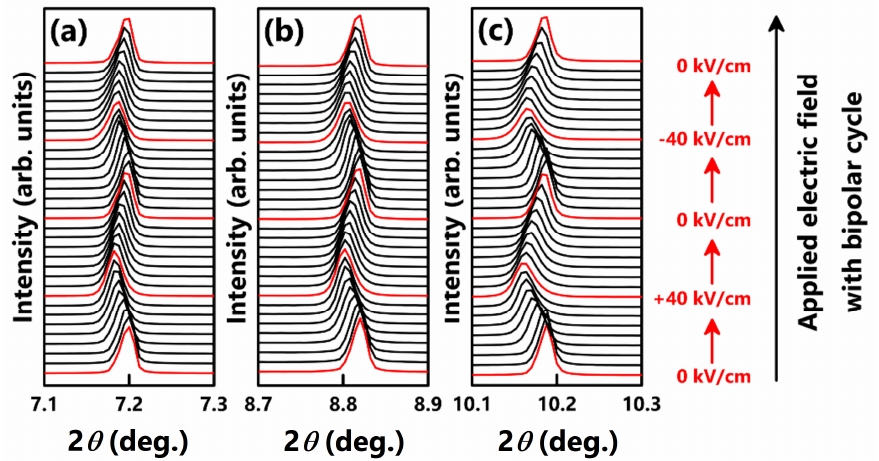
Figure 20. In-situ synchrotron X-ray diffraction of 0.67BiFeO 3 –0.33BaTiO 3 ceramics under the AC cycling from −40 kV/cm to +40 kV/cm with selected angle for ( a ) (110) peak, ( b ) (111) peak, and ( c ) (200) peak. Reprinted with the permission of [144]. Copyright © 2021 Journal of the Ceramic Society of Japan.